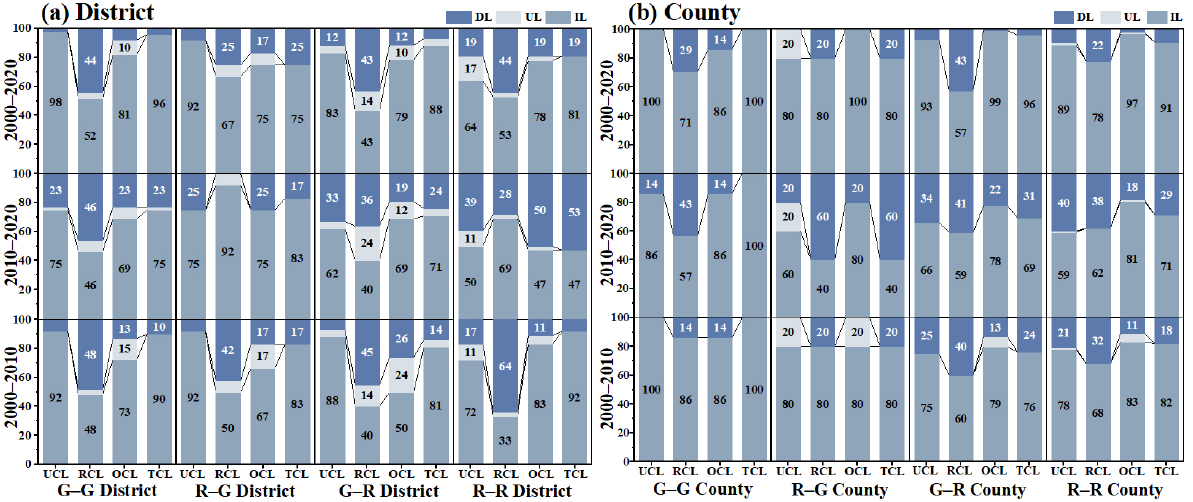
Figure 5. Comparison of construction land percentage change in different research unit types. ( a ) District; ( b ) county.